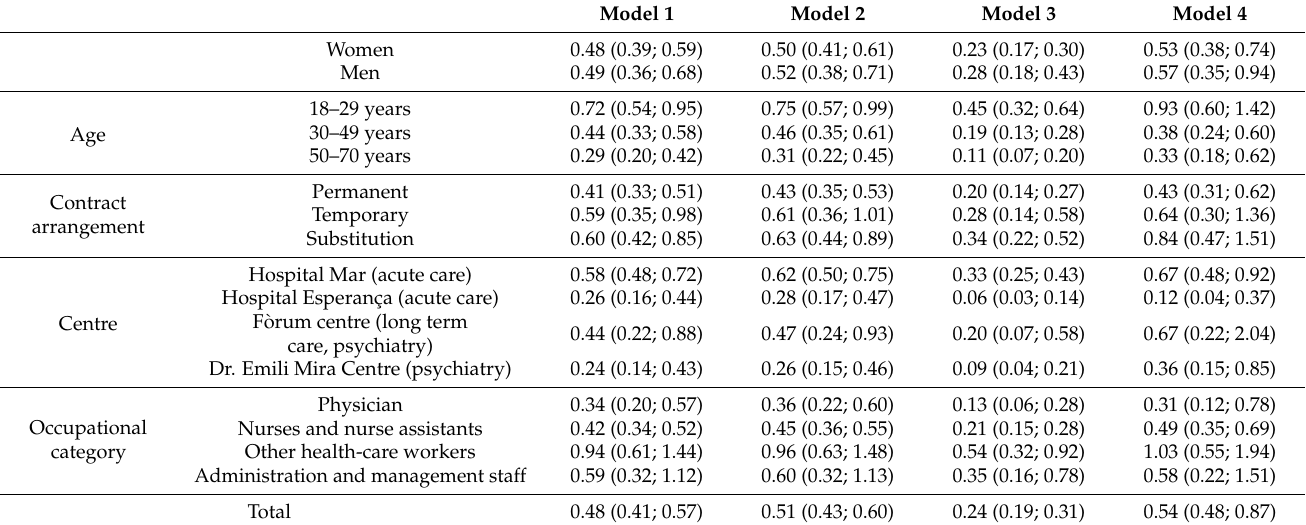
Table 2. Rate ratio (95%CI) of incident COVID19 cases between waves among PSMar healthcare workers, 2020. Crude and adjusted negative binomial regression models by sex, age, contract arrangement, health building centre, and occupational